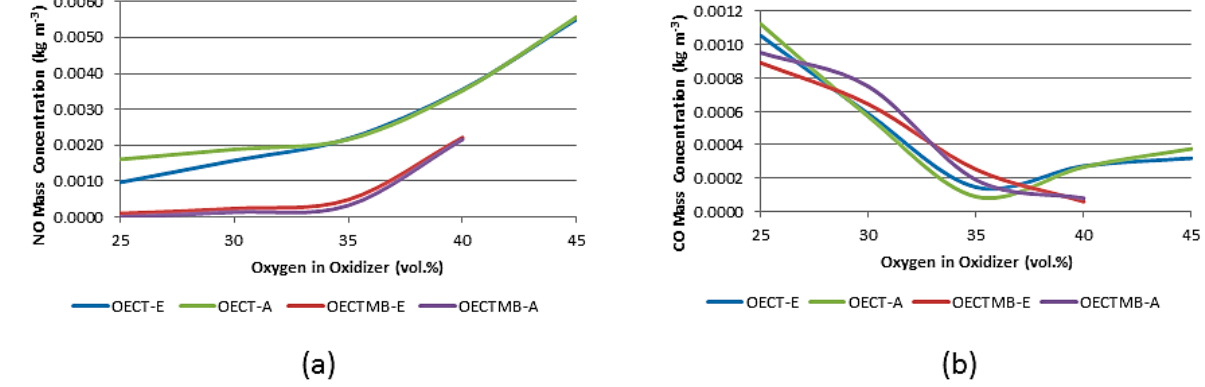
Figure 17. Verification of CFD model. ( a ) NO mass concentration; ( b ) CO mass concentration.